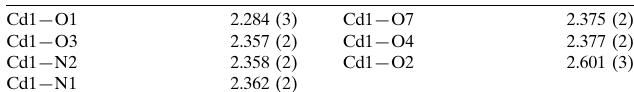
Selected bond lengths (A˚ ).